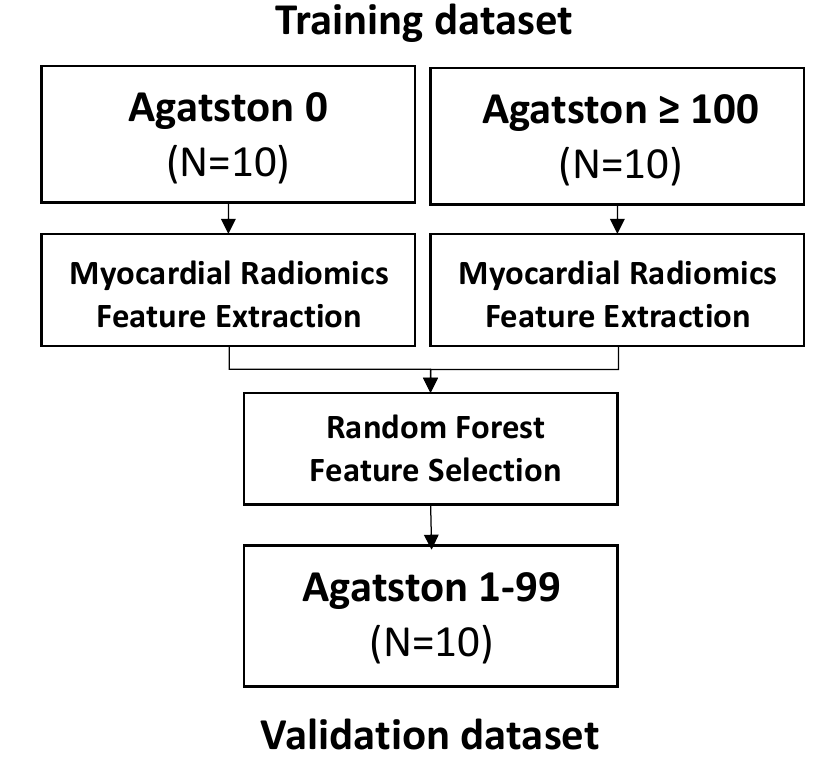
Figure 1. Consort flow diagram.